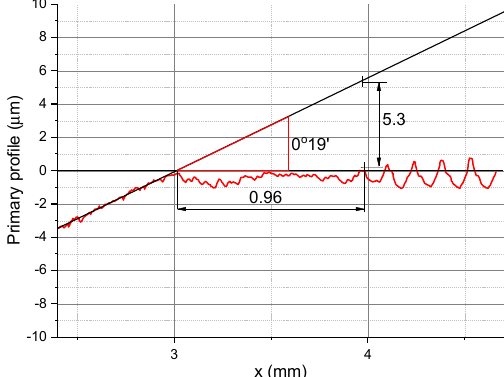
Figure 3. Determining h min from a surface profile obtained with a contact profilometer ( v c = 360 m/min, f = 0.03 mm/rev, and r n = 49.9 µm).